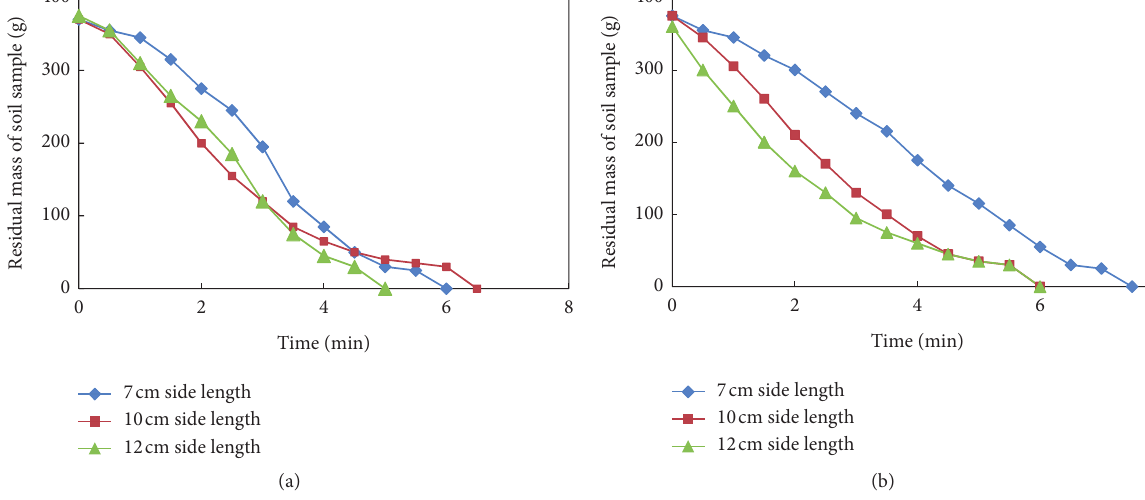
Figure 5: Disintegration curve of soil samples with the same volume and different diameter, (a) − 18 cm, (b) − 30 cm, (c) − 42cm.